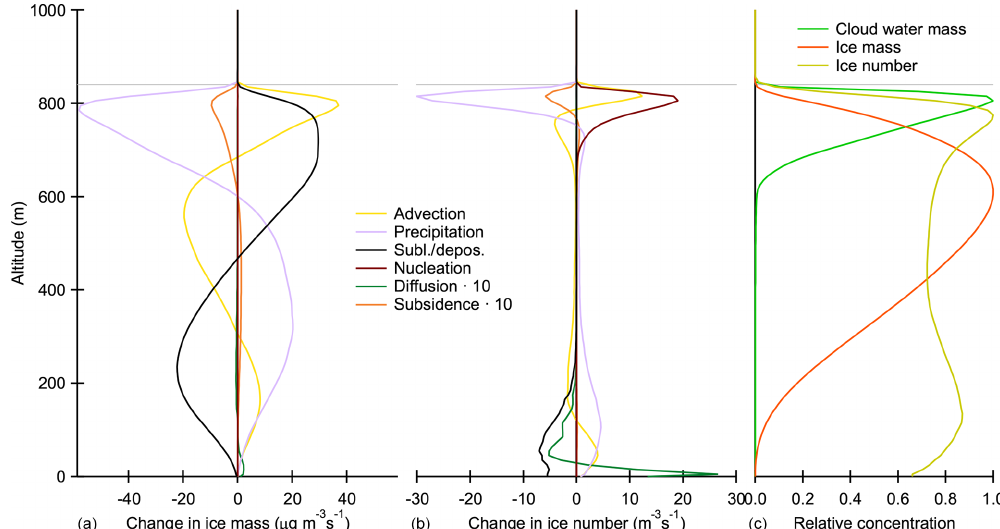
Figure 7. Horizontally averaged profiles of the main processes affecting on ice mass (a) and number (b) concentrations. Diffusion and subsidence are multiplied by a factor of 10 for clarity. Cloud water and ice mass mixing ratios and ice number concentration profiles normalized by their maximum values are shown in panel (c) . The profiles are 1h averages of the eighth simulation hour from the simulation with high background INP concentration and marine INP emissions switched on. Cloud top height (840m) is indicated by the horizontal lines.